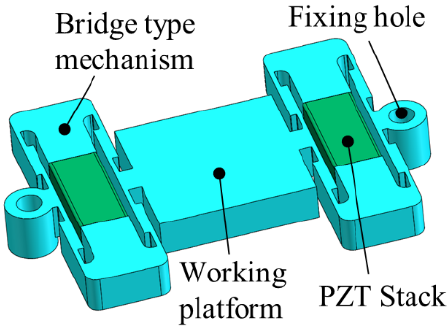
Figure 3. The series bridge PZT actuator.